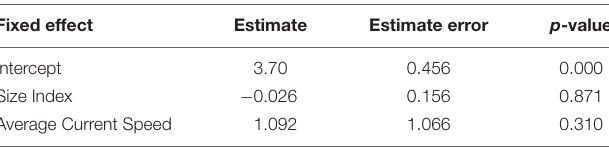
TABLE 5 | Results of a linear mixed effects model predicting neonate average true swimming speed (body lengths in m s − 1 ) as a function of average current speed (m s − 1 ) and a PCA-derived body size